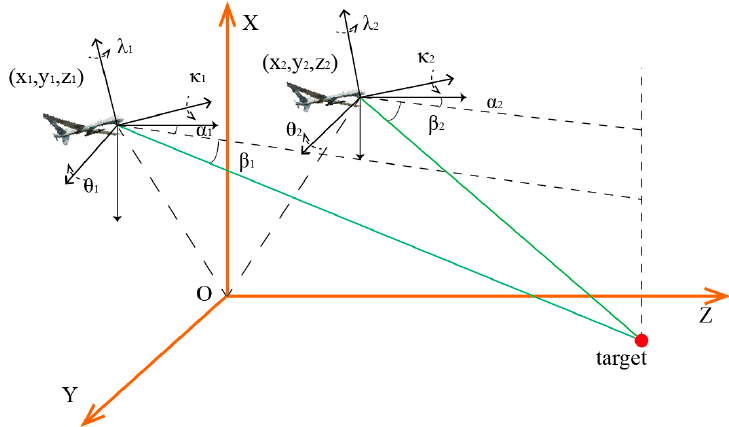
Figure 3. Schematic diagram of two-UAV intersection localization.